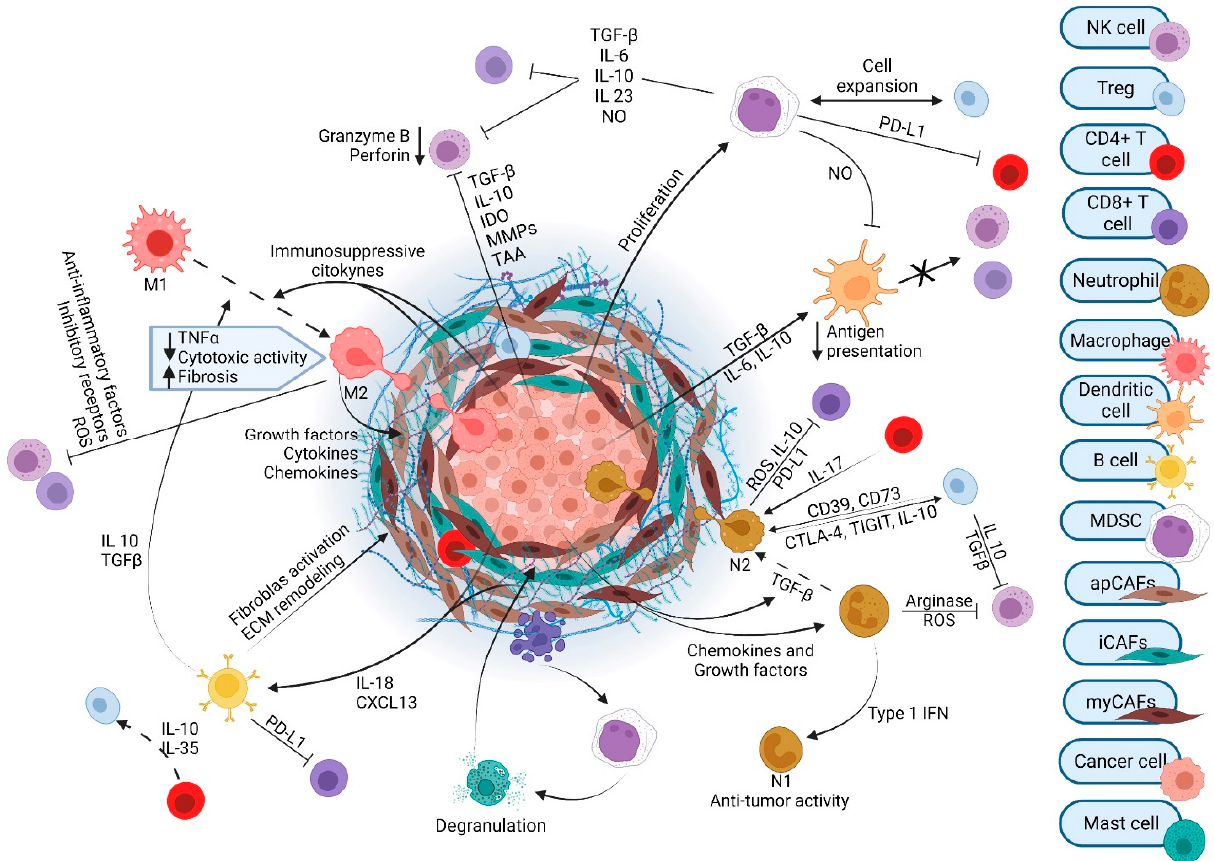
Figure 1. The tumor microenvironment of pancreatic ductal adenocarcinoma.